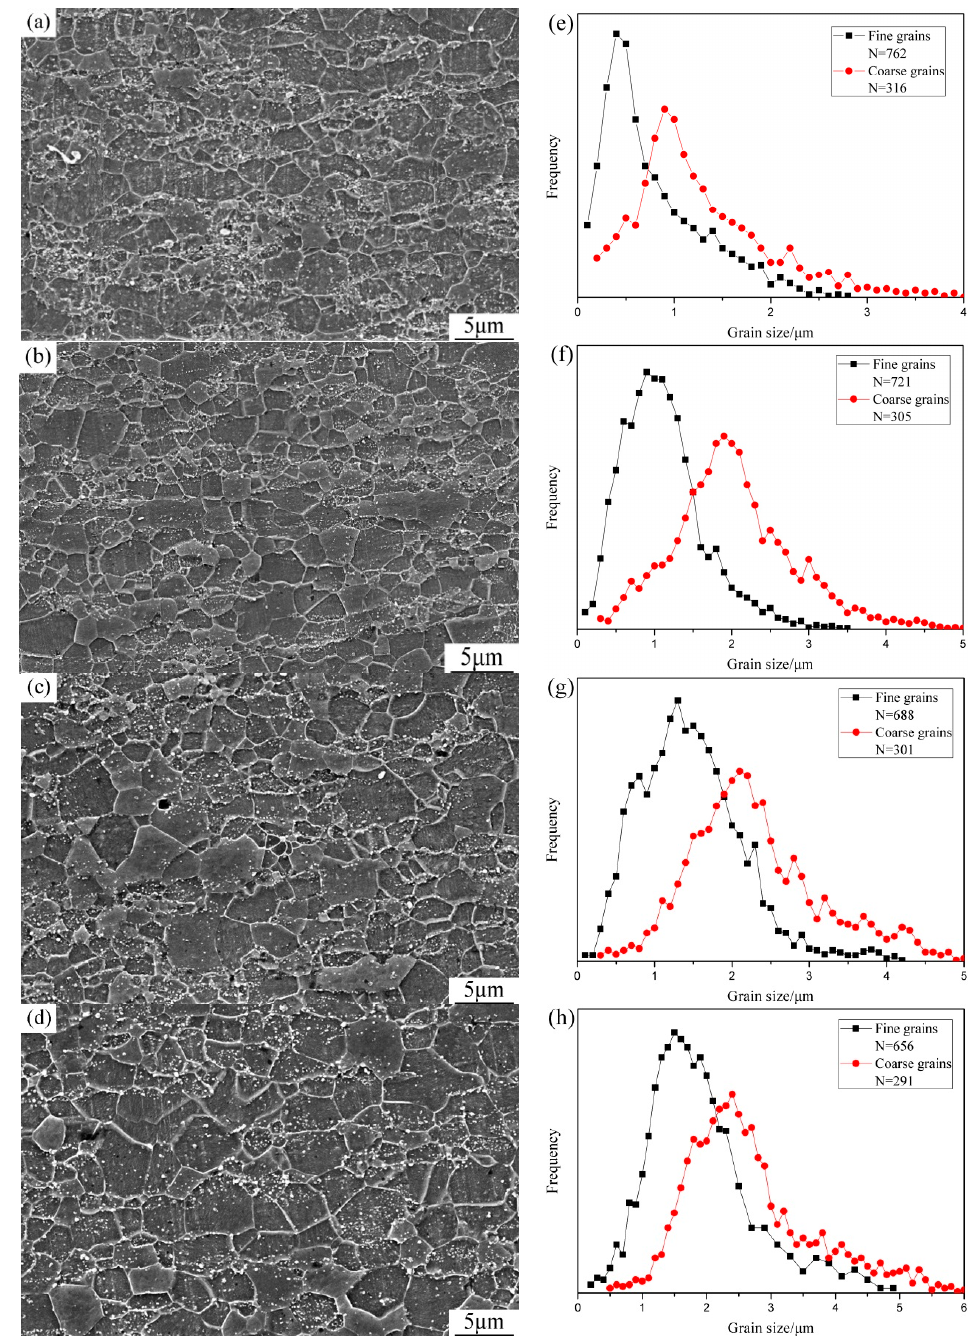
Figure 2. The annealed microstructures at 650 °C and different holding times, and the corresponding diagrams of grain size distribution. Number of the measured grains (N) was given. ( a , e ) 30 min; ( b , f ) 40 min; ( c , g ) 50 min; ( d , h ) 70 min.